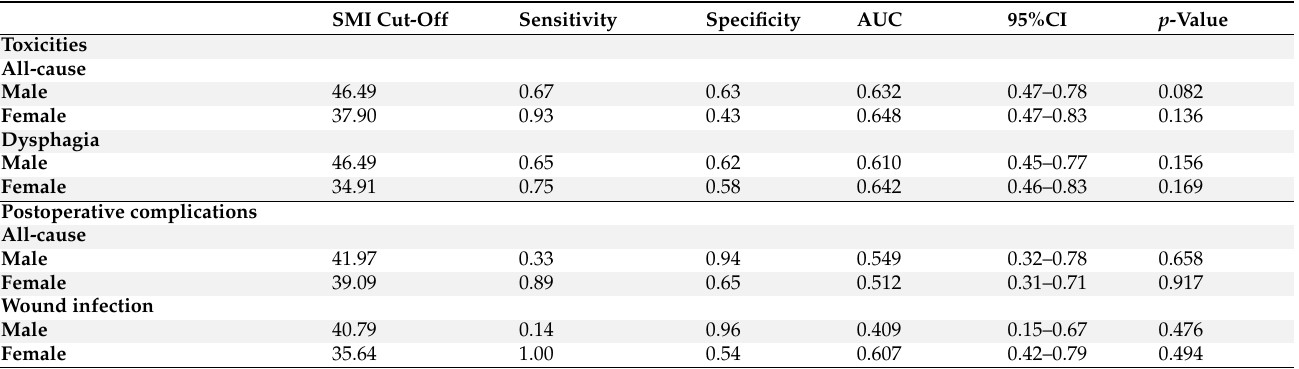
Table 3. SMI cut-off values based on the occurrence of adverse events endpoints. AUC, sensitivity and specificity per SMI cut-off value are